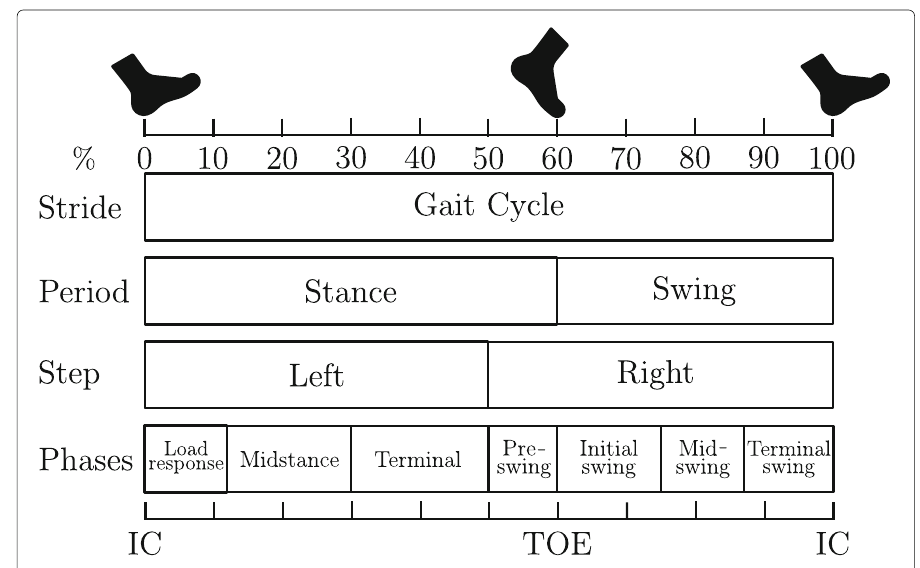
Fig. 3 Gait events and gait phases in one gait cycle. The gait cycle is divided into stance and swing phase. Stance starts from IC to terminal contact TOE. Stance phase nearly represents about 60% of gait cycle. Swing phase begins as soon as the toe leaves the ground, and ends just prior to IC. Swing phase occupies the rest 40% of the gait